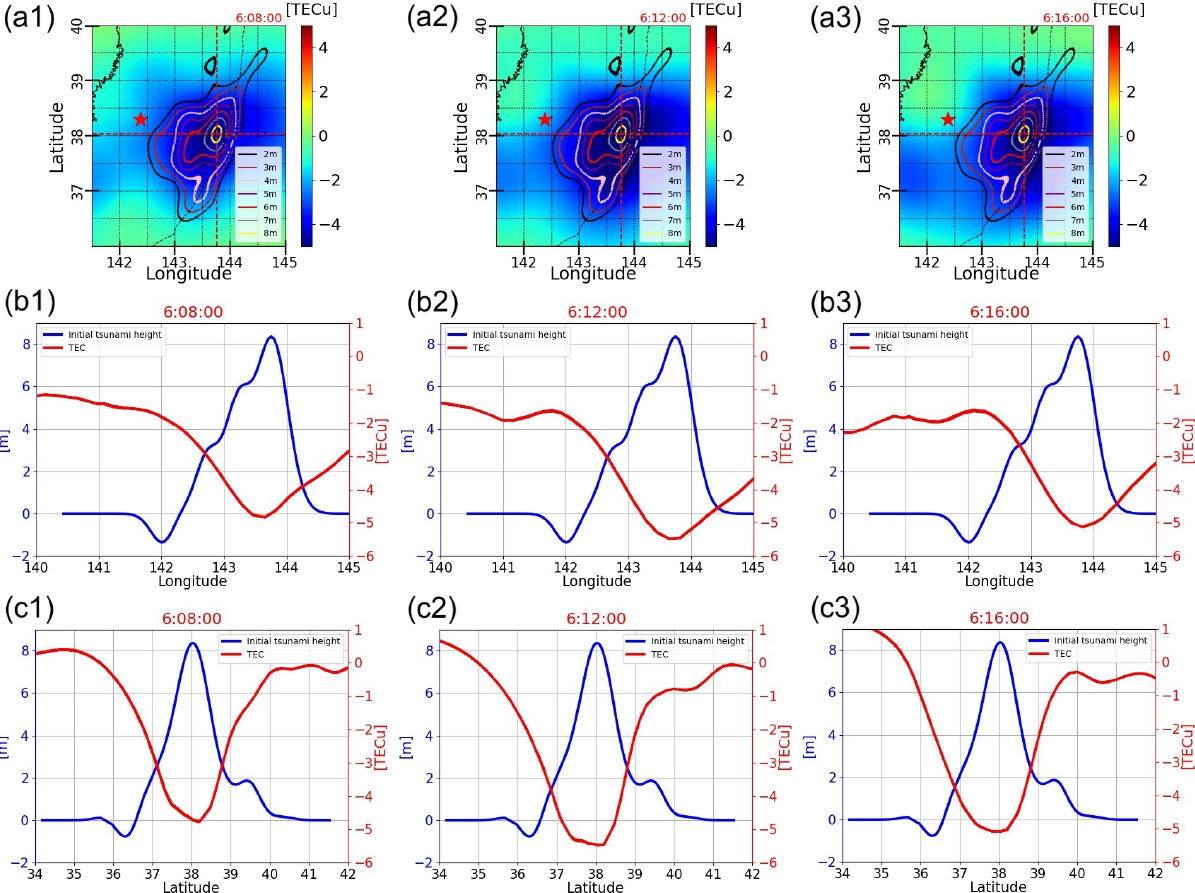
Figure 13. Overlap of initial tsunami and TEC. Panels (a1–a3) are plots of TEC values and contours of the initial-tsunami height by T. Saito et al. (2011). The horizontal and vertical red dashed lines indicate the latitude and longitude where the initial tsunami reaches its highest height. Panels (b1–b3) and (c1–c3) show the initial-tsunami height and TEC values at the latitude and longitude where the initial-tsunami height is the highest, respectively. The initial-tsunami height corresponds to the scale on the left axis (blue), and the TEC value corresponds to the scale on the right (red).